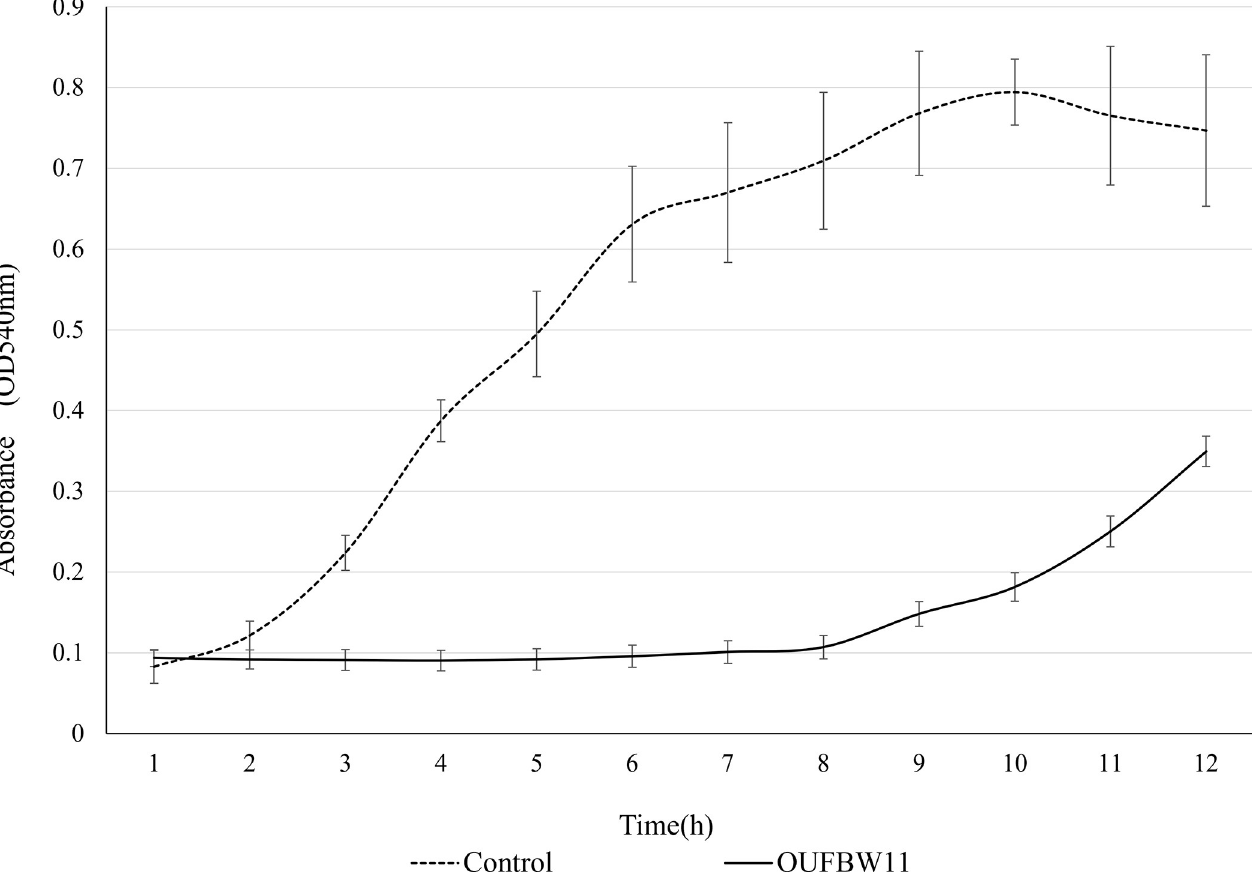
Fig 5. Alamar Blue assay of C . albicans after exposure to OUFBW. Candida metabolic activity was determined by incubating specimens in a TSBD medium containing Alamar Blue and measuring absorbance. ( � : p < 0.05).